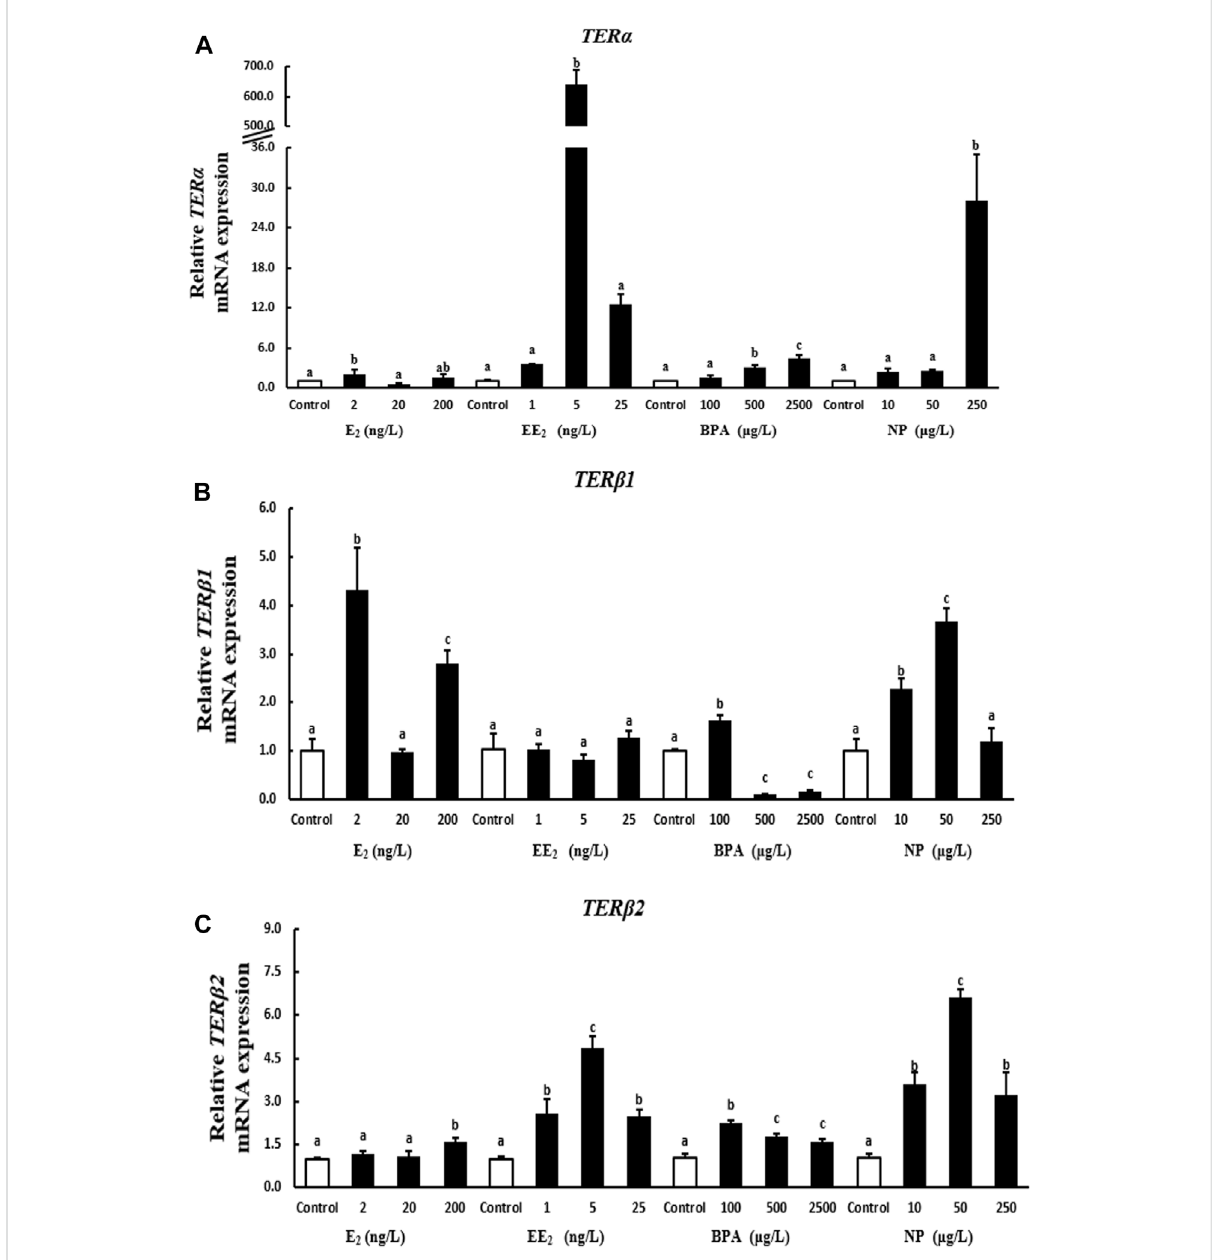
FIGURE 3 Effects of EDCs on the expression of ter α (A) , ter β 1 (B) , and ter β 2 (C) in the liver of T. albonu bes. Columns with different letters are signi fi cantly different at p < 0.05 according to one-way ANOVA followed by Dunnett ’ s